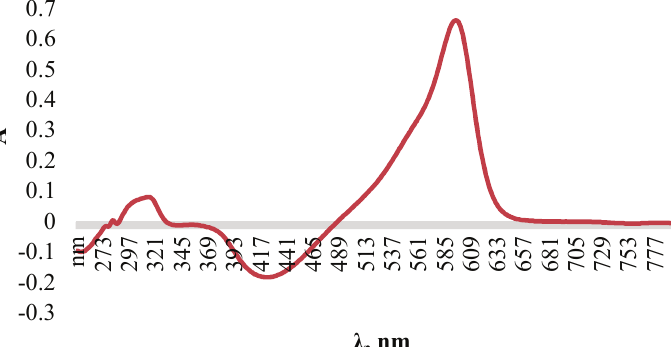
Fig. 1. The spectrum of absorbance of the reaction product of